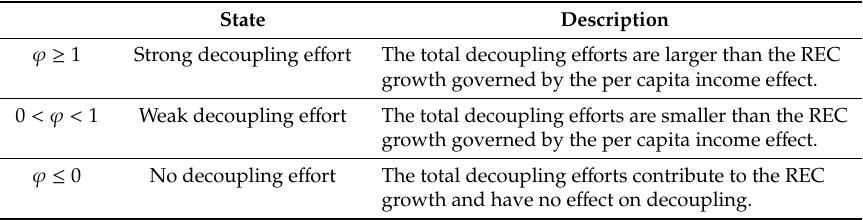
Table 3. Criteria of decoupling e ff ort.